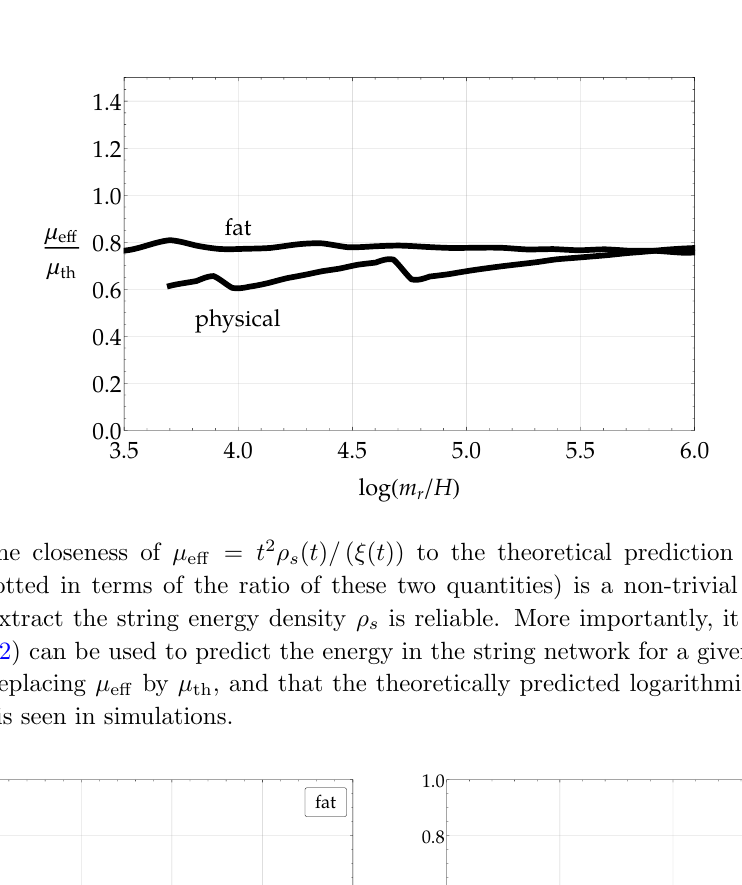
physical one. Data at later time may not be safe from (cid:12)nite volume e(cid:11)ects (see appendix